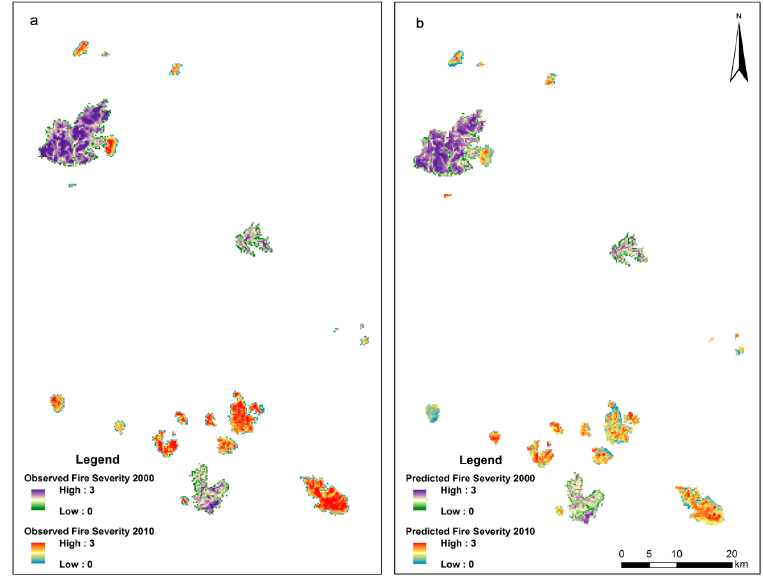
Figure 4. Observed fire severity ( a ) aggregated from Landsat observations versus the modeled fire severity ( b ) for 21 fires based on boosted regression tree models. All fire severity images were plotted at 240 m spatial resolution.